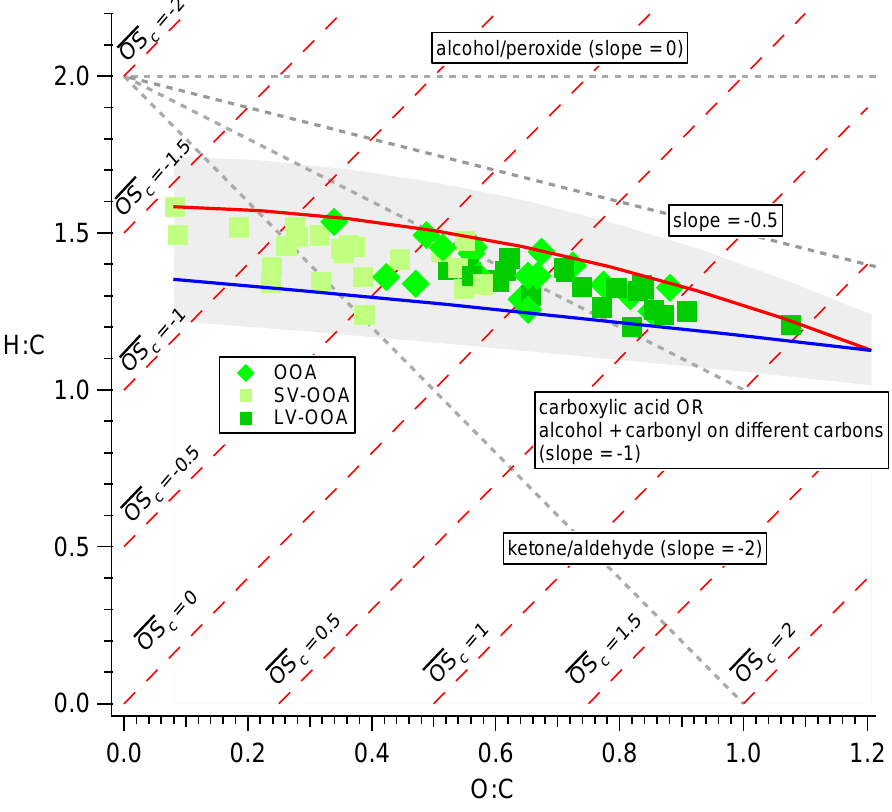
Fig. 4. Representation of all the OOA components into the VK-triangle diagram. The left and right sides of the triangle plot become the bottom and top lines in the Van Krevelen diagram, respectively. The light gray shaded region denotes the ± 10% uncertainty in the parameterization. The estimated carbon oxidation states (OS C ≈ 2 O/C − H/C) are shown with the red dotted lines.